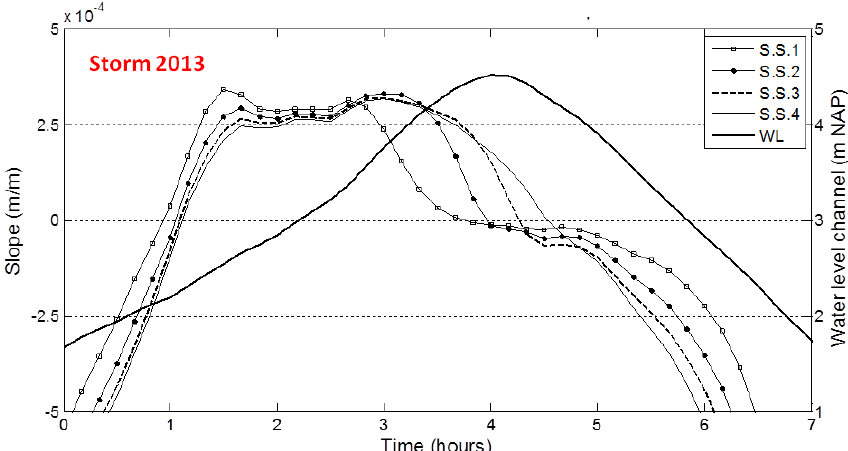
Figure 10. Water surface slope between main estuarine channel and wetland edge (distance between them was about 1000m) simulated for the storm tide of 2013 for different schematic scenarios with different wetland surface